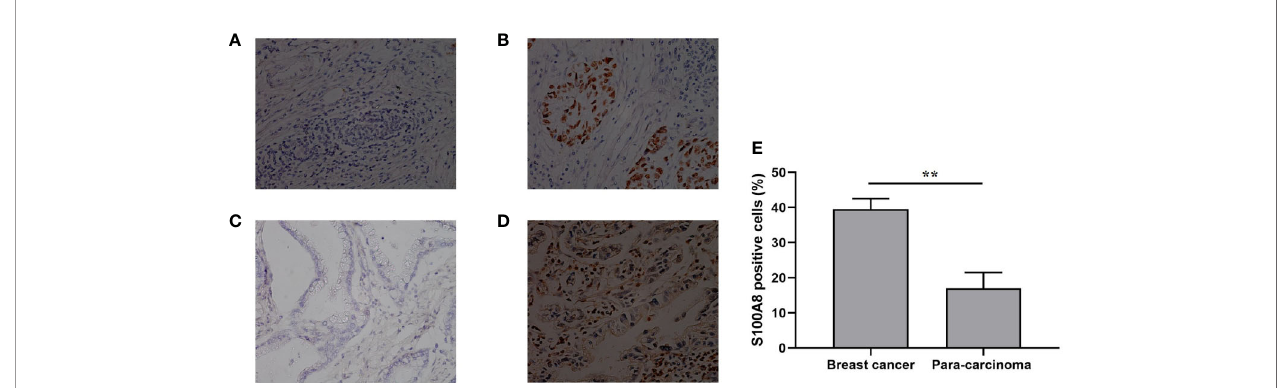
FIGURE 8 | Immunohistochemical examination of the expression of S100A8. (A) Para-carcinoma tissue of breast cancer (female, aged 51, magni fi cation, ×200); (B) breast cancer tissue (female, aged 51, magni fi cation, ×200); (C) para-carcinoma tissue of bladder cancer (male, aged 69, magni fi cation, ×200); (D) bladder cancer tissue (male, aged 69, magni fi cation, ×200). (E) The proportion of S100A8 positive cells in breast cancer and its corresponding para-carcinoma tissues (n = 112). **means p < 0.01.